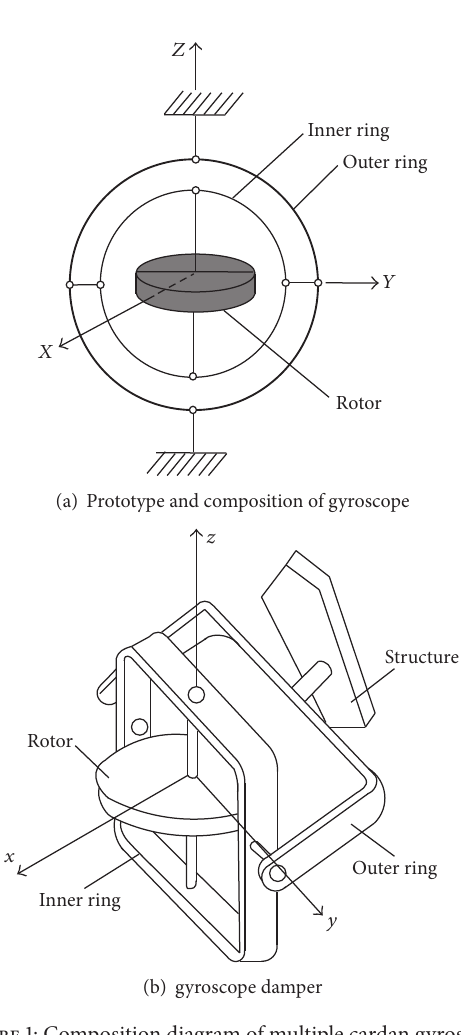
Figure 1: Composition diagram of multiple cardan